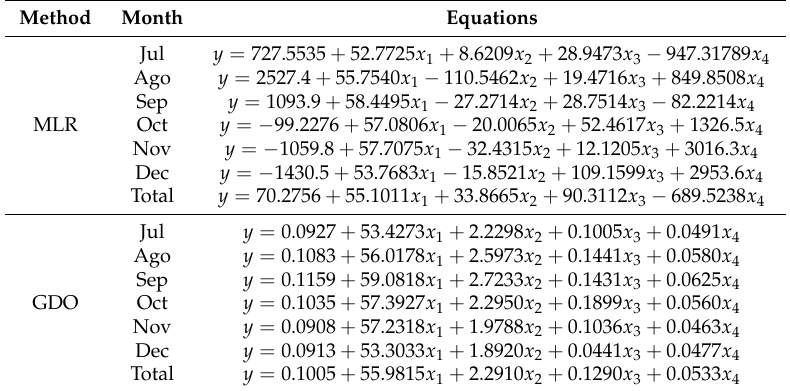
Table 3. Monthly and overall MLR and GDO equations for